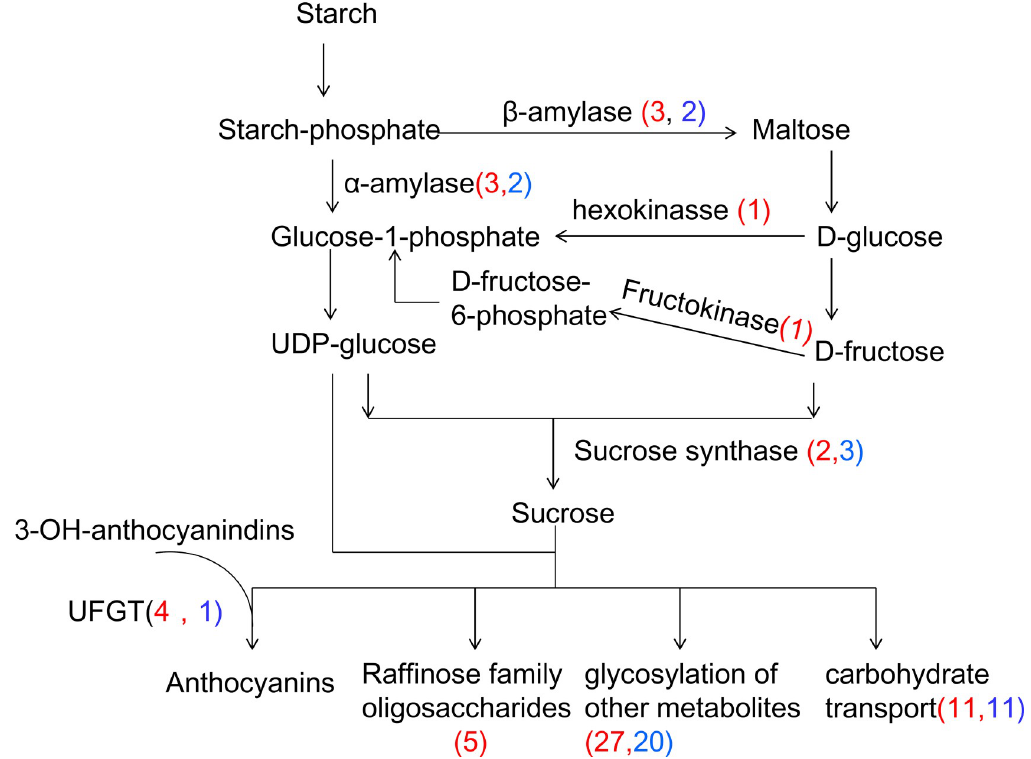
Fig 10. Effect of cold on starch and sucrose metabolism. UFGT:anthocyanidin 3-O-glucosyltransferase.